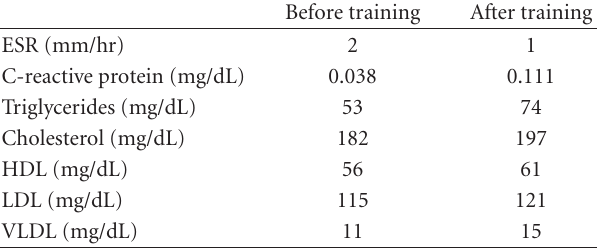
Table 2: Blood markers for inflammation and lipids.